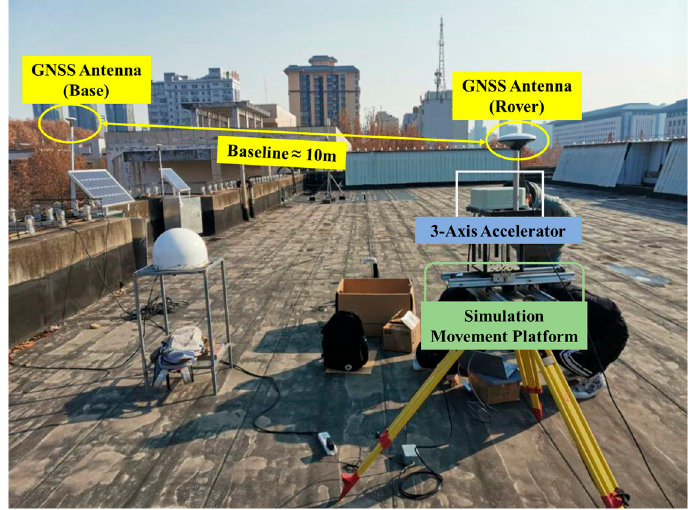
Figure 3. Schematic diagram of the experimental equipment installation. Table 1. Accelerometer performance specifications.